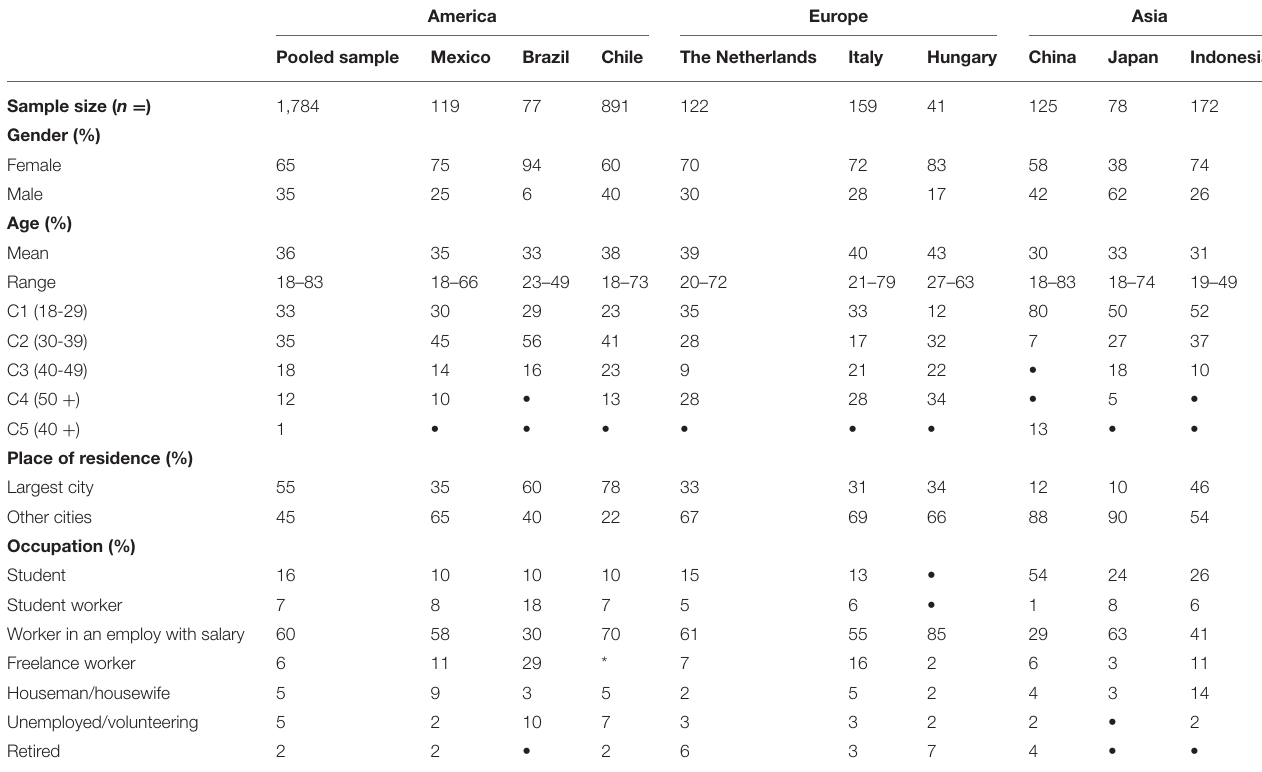
TABLE 2 | Sample demographics by pooled sample and by